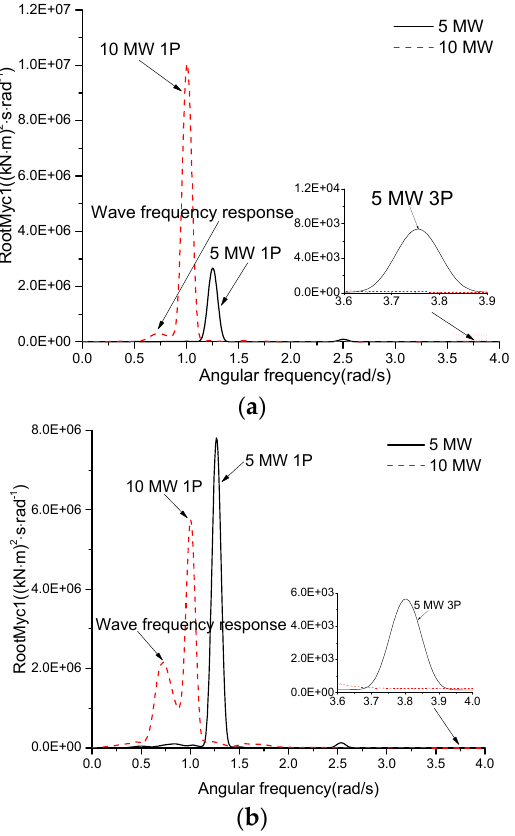
Figure 16. Comparison of the power spectra of RootMyc1 response. ( a ) Power spectra of RootMyc1 response for the LC3 case; ( b ) power spectra of RootMyc1 response for the LC6 case.